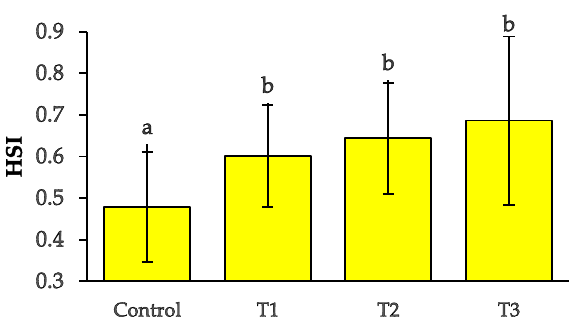
Figure 4. Hepatosomatic (HSI) indices in different treatment groups. Different superscripts indicate significant differences at p < 0.05.